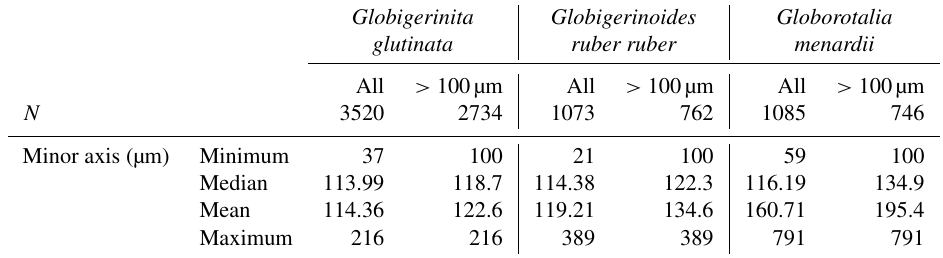
Table A1. Size variability (minor axis, in µm) of the measured specimens of planktonic foraminifera per species over the study when all and only specimens larger than 100µm are considered, with N being the exact number.